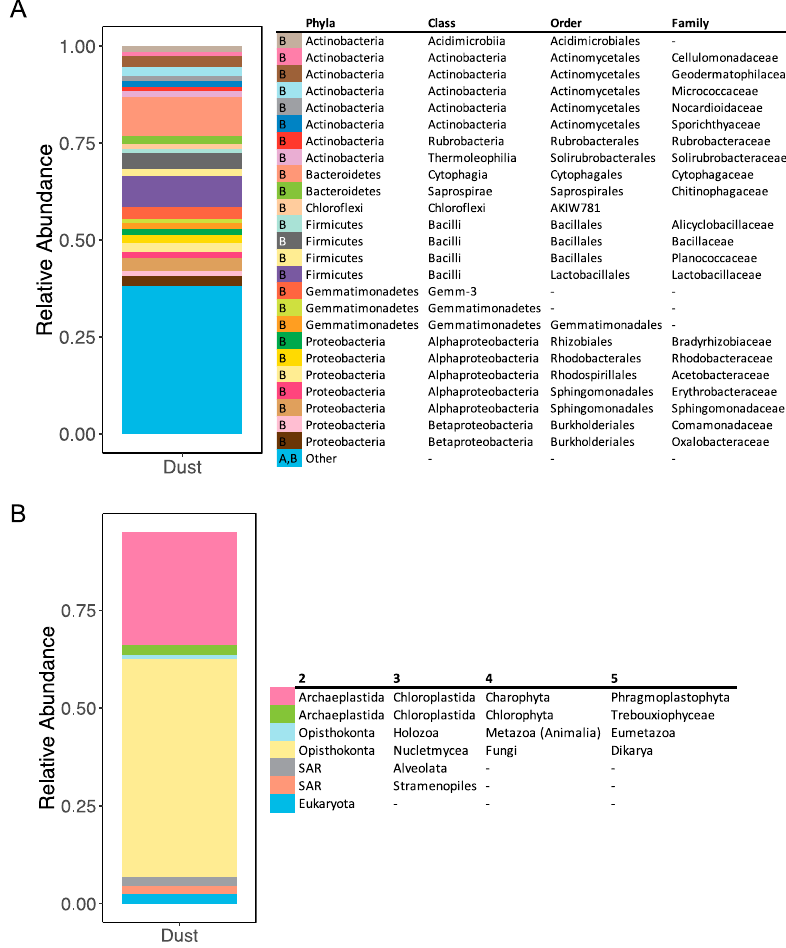
Figure 4. Relative abundance of prokaryotes ( A ) and eukaryotes ( B ) in the aerosols collected during the dust storm. The last row in both legends is the sum of all rare taxa (constituting < 5% of relative abundance). In (A), A and B in the first column of the legend corresponds to archaea and bacteria, respectively. In (B), column names 2–5 represent taxonomic levels.